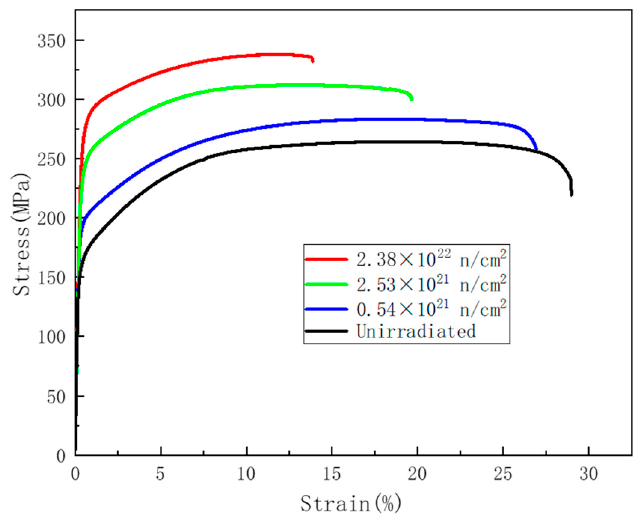
Figure 4. Stress–strain curve of the tensile specimen with different irradiation fluence.